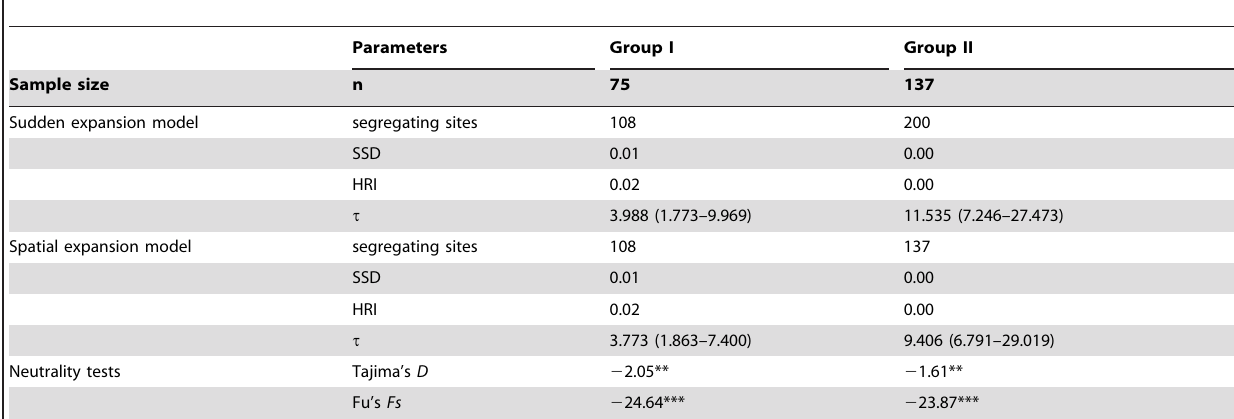
Table 3. Mismatch distributions analyses of sudden- and spatial-expansion models and neutrality tests of Groups I and II.